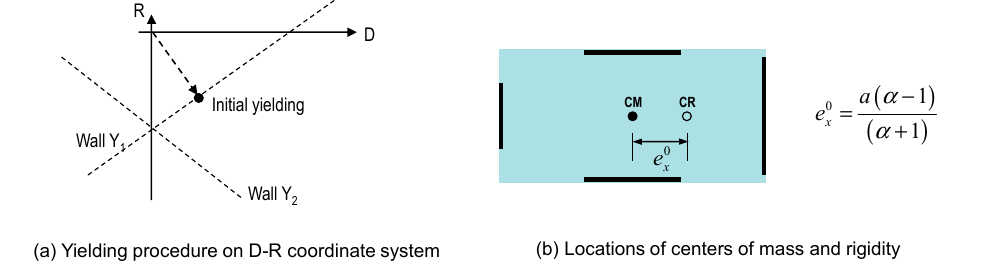
Figure 5. Yielding procedure: Linear elastic stage.